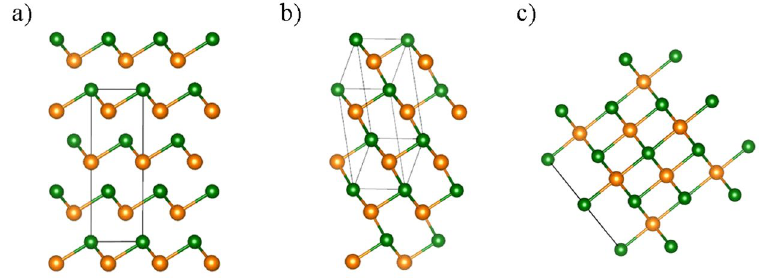
Figure 1. Atomic images of ( a ) P1 or R3m, ( b ) Cm, and ( c ) Fm3m structures. The P1 and R3m structures feature three short and three long bonds. P1 and R3m cannot be distinguished from structural images owing to their structural similarity. The Cm structure features two short, two intermediate, and two long bonds. The Fm3m structure features six identical